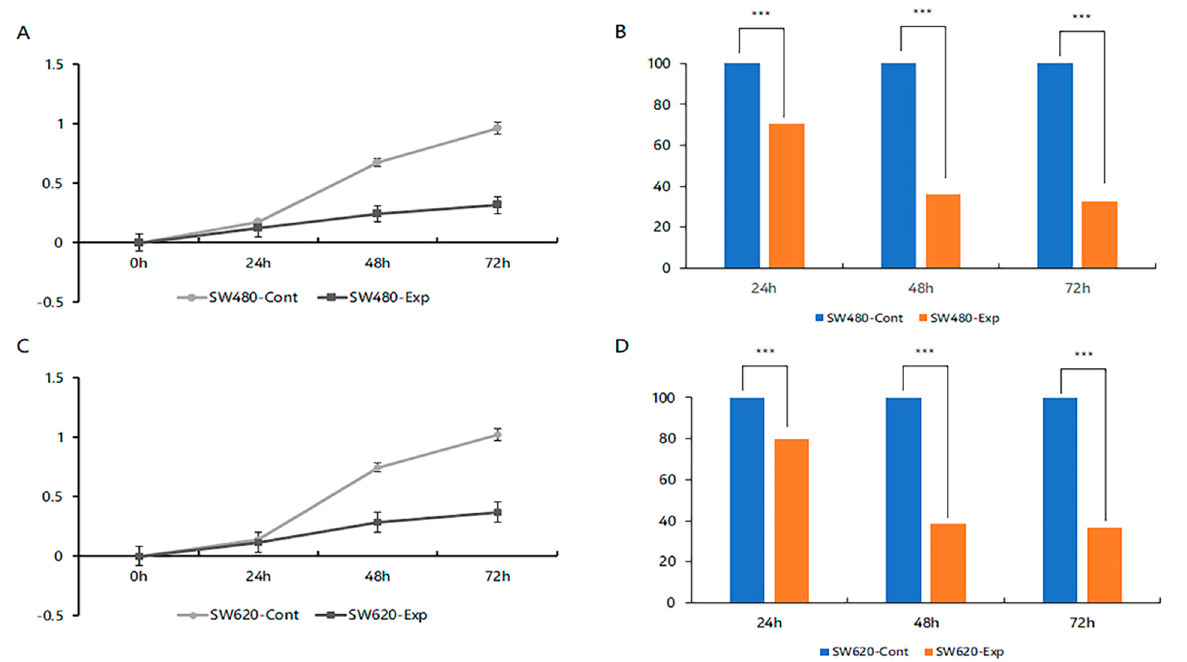
Figure 3. Proliferation test by siTSPAN5. ( A , B ) Proliferation graph of SW480 control and siTSPAN5 cells. ( C , D ) Proliferation graph of SW620 control and siTSPAN5 cells (*** p <